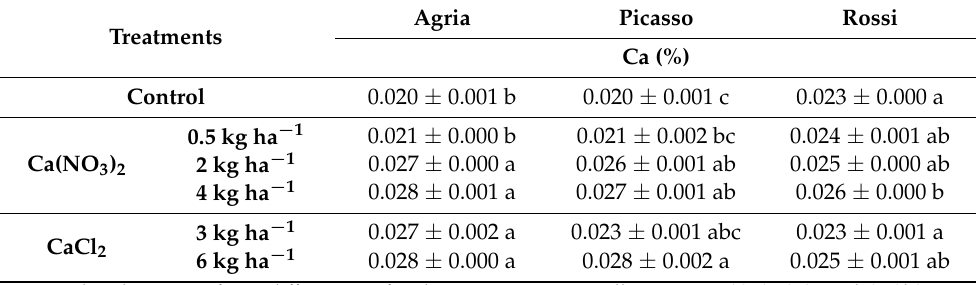
Table 2. Mean values of Ca contents ± S.E. ( n = 4), at harvest, in whole the tubers of Solanum tuberosum L., varieties Agria, Picasso and